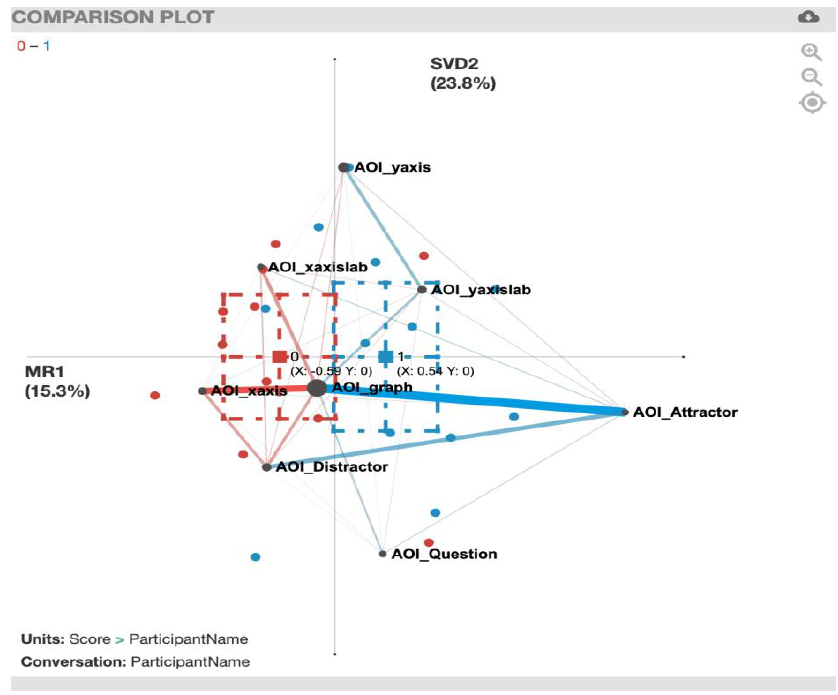
Figure 11 . EcSlopeQuant transitions with incorrect solvers (red) and correct solvers (blue).